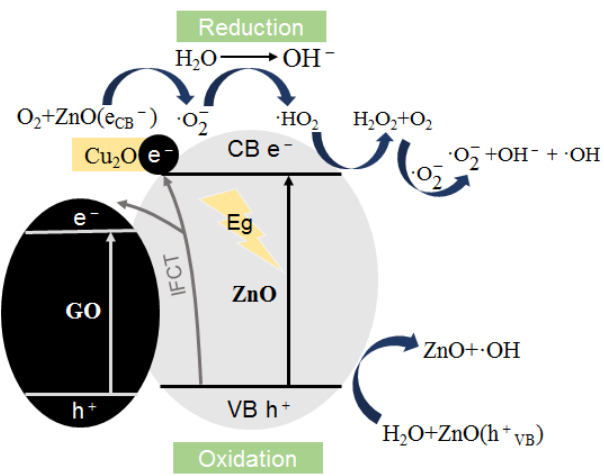
Figure 12. Schematic diagram of the mechanism of ROS formation.